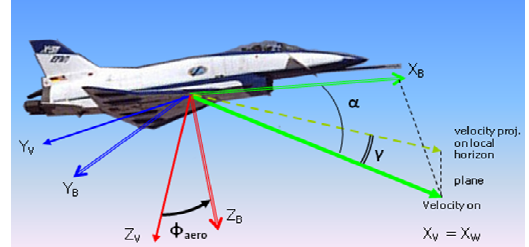
Fig 2. Definition of the velocity fixed reference frame (V or VEL) and the attitude of the vehicle with respect to it. In this figure, no wind and wind gust presence is assumed in order to better illustrate relation with body frame